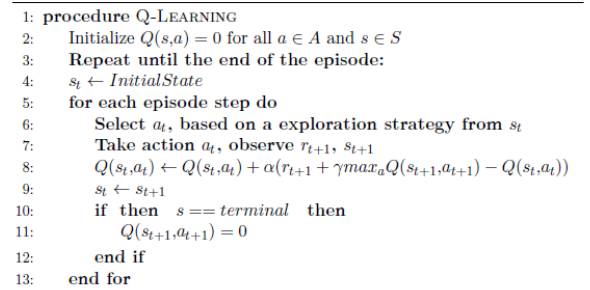
Figure 7. Q-learning